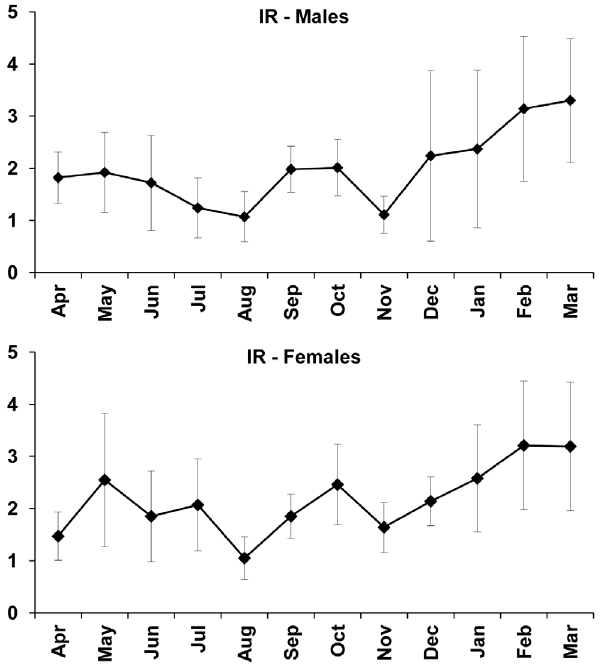
Figure 7. Repletion index. Monthly variation of mean repletion index (RI) for Brachyhypopomus gauderio males and females from April/2005 to March/2006. Vertical bars represent the standard deviation. Numbers above the bars correspond to the numbers of specimens included in the analysis.